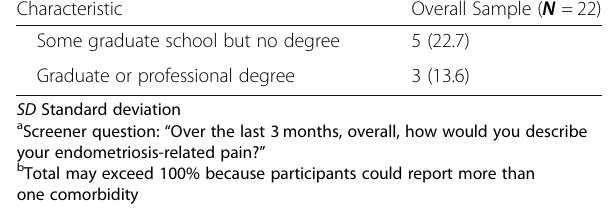
Table 1 Demographic and clinical characteristics collected